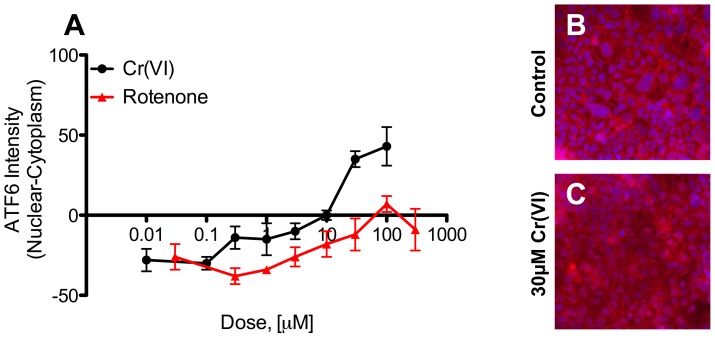
ATF6 localization in differentiated Caco-2.(A) Difference between nuclear and cytoplasmic expression of ATF6. Positive slope indicates translocation of ATF6 into the nucleus. (B) Dual channel overlay of Hoechst (blue) and ATF6 (red) fluorescence in untreated Caco-2 cells. Blue nuclei indicate relative absence of ATF6 in nucleus. (C) Dual channel overlay of Hoechst and ATF6 fluorescence in Caco-2 treated with 30 µM Cr(VI) for 24 hr. Loss of blue nuclei indicate movement of ATF6 into the nucleus. Data are plotted as mean ±s.d. (n = 3, where n is number of individual replicas).